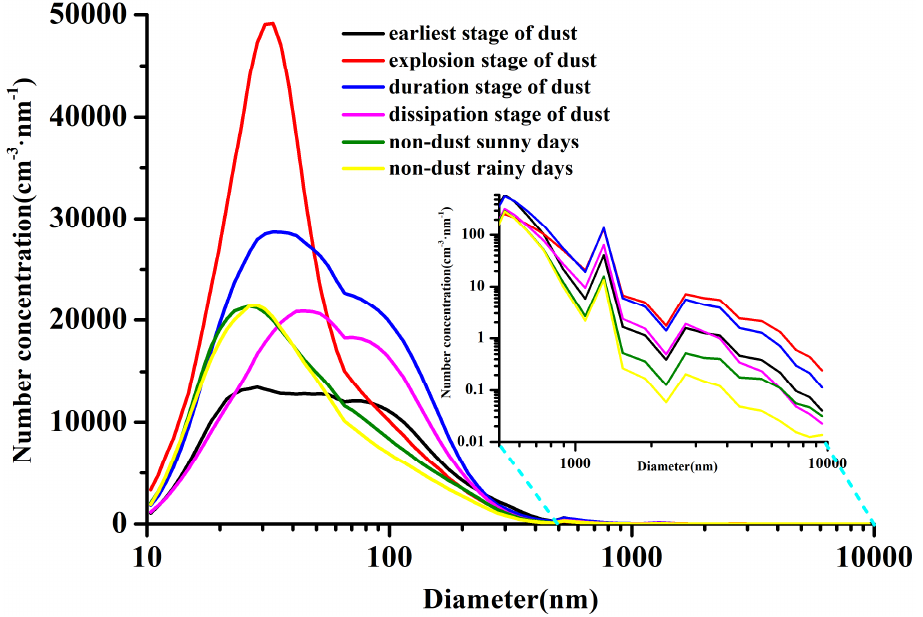
Figure 6. Size distribution of aerosol number concentrations during the different dust stages.